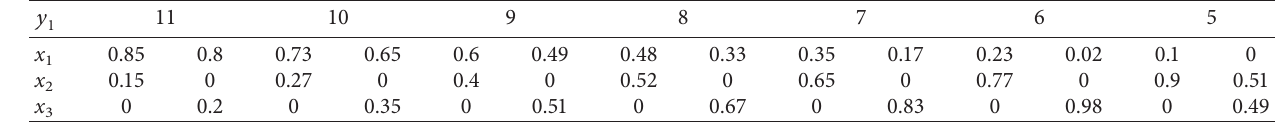
Table 9: Compressive strength y 1 regression equation